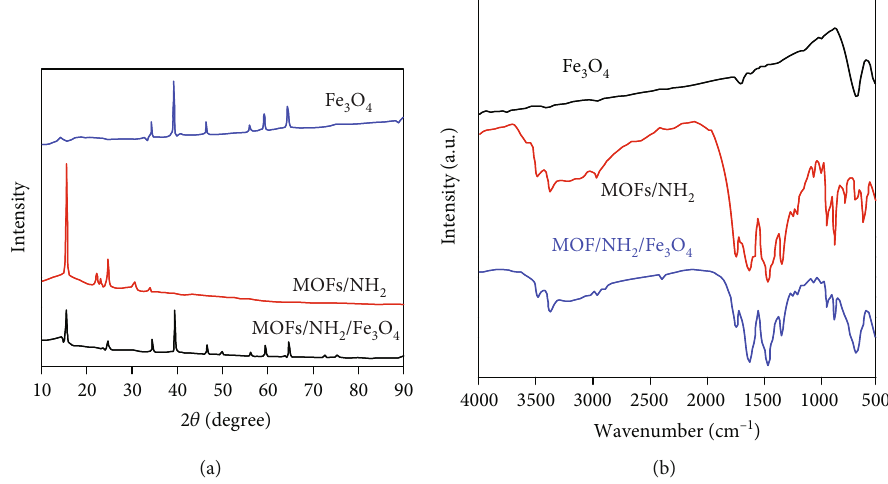
Figure 1: XRD (a) and FT-IR (b) of the synthesized Fe